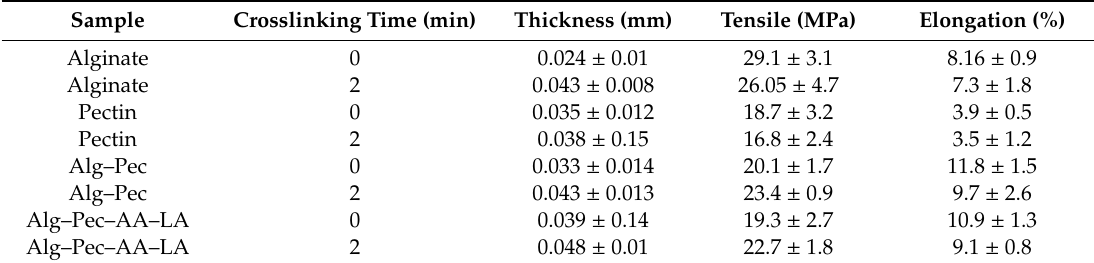
Table 3. Tensile properties of the alginate, pectin, and their biocomposite films before and after crosslinking a .